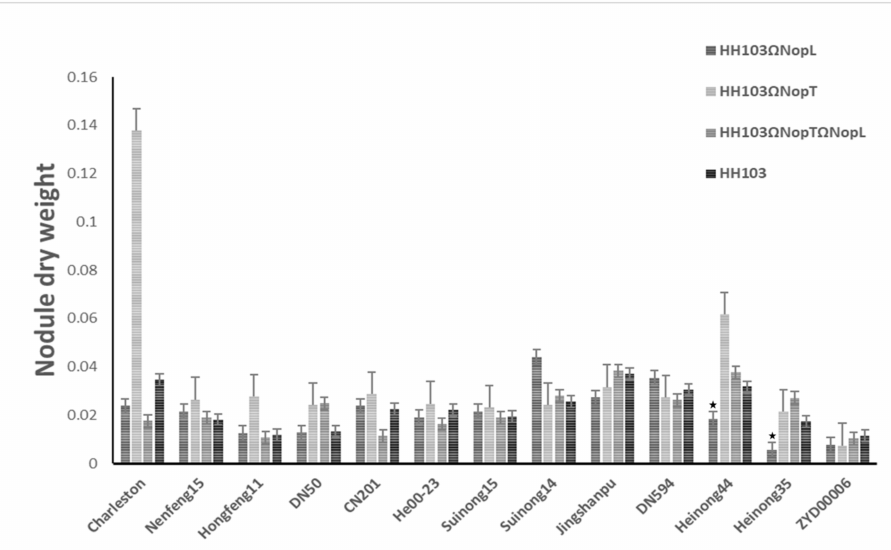
Figure 2. Nodule dry weight phenotype of soybean germplasm after inoculation with S. fredii HH103 and S. fredii HH103 Ω NopL , HH103 Ω NopT and HH103 Ω NopL Ω NopT . Nodulation tests were performed three times; t -test was performed comparing the NopP mutant to the wild- type strain; when significant (0.01 ≤ p ≤ 0.05), an asterisk * is shown. Ecoregions origin of germplasms: Charleston (America), Nenfeng15 (Heilongjiang), Hongfeng11 (Heilongjiang), Dongnong50 (Heilongjiang), CN201 (Sichuan), He00-23, Suinong15 (Heilongjiang), Suinong14 (Hei- longjiang), Jingshanpu (Heilongjiang), Dongnong594 (Heilongjiang), Heinong44 (Heilongjiang), Heinong35 (Heilongjiang),